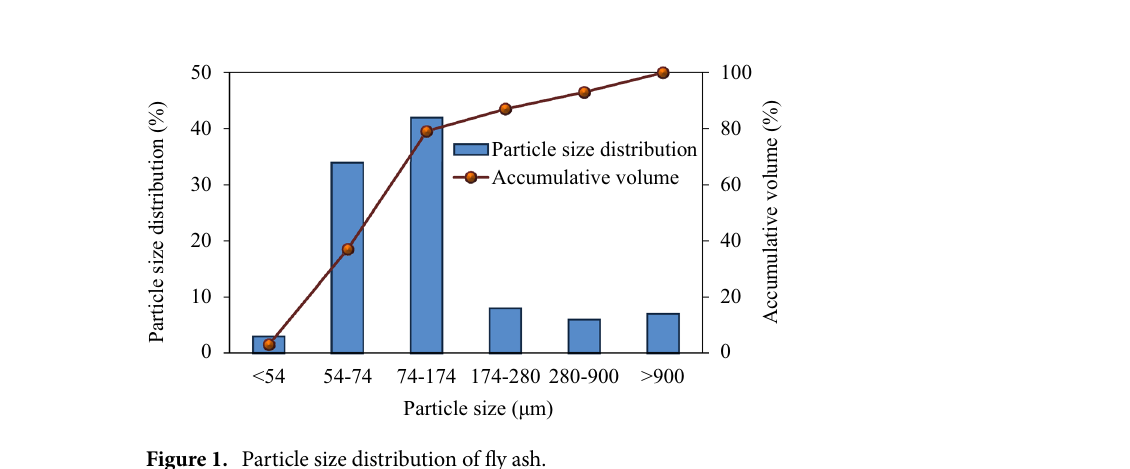
Table 4. Heavy metals contents of predried ES and bituminous coal (mg/kg).